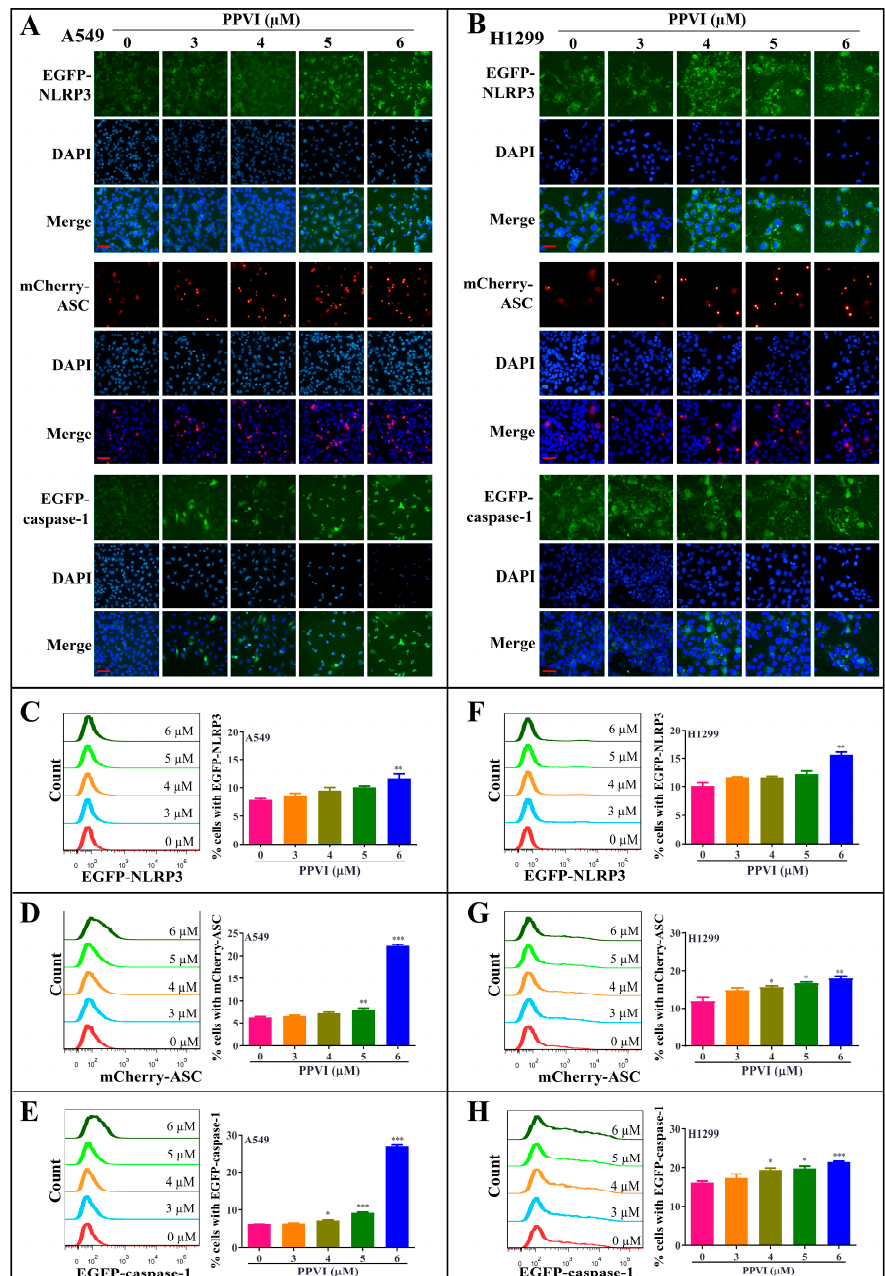
Figure 4. PPVI increased the expression of NLRP3, ASC and caspase-1 in A549 and H1299 cells. A549 cells ( A ) and H1299 cells ( B ) transiently transfected with EGFP-N1-NLRP3, mCherry-C1-ASC and EGFP-N1-caspase-1 plasmids for 24 h were treated with PPVI as indicated by the graded concentrations for another 24 h. After treatment, the cells were fixed with 4% PFA, and the representative images were captured using the fluorescence microscope. Magnification: 40×. Scale bar: 25 µ m. A549 cells ( C – E ) and H1299 cells ( F – H ) transiently transfected with EGFP-N1-NLRP3, mCherry-C1-ASC and EGFP-N1-caspase-1 plasmids for 24 h were then treated with PPVI as indicated by the graded concentrations for another 24 h. After treatment, the cells were trypsinzed and collected for the analysis of fluorescence intensity by flow cytometry. Bar chart indicates the percentage of cells with GFP or mCherry signal in A549 and H1299 cells; bars, S.D. * p ≤ 0.05; ** p ≤ 0.01; *** p ≤